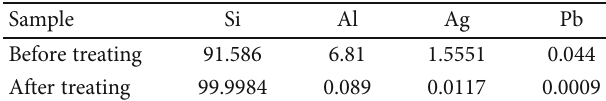
Table 1: ICP-MS analysis of weight percentage of each element present in wafer.